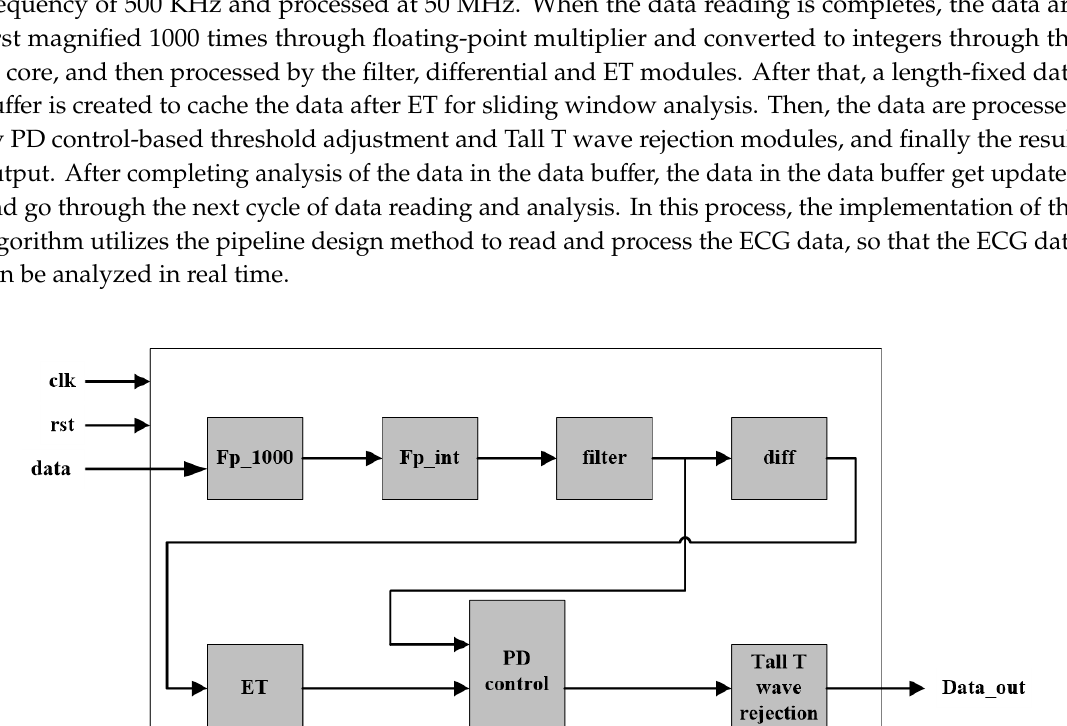
Figure 8. Architecture of the hardware implementation of the proposed algorithm.